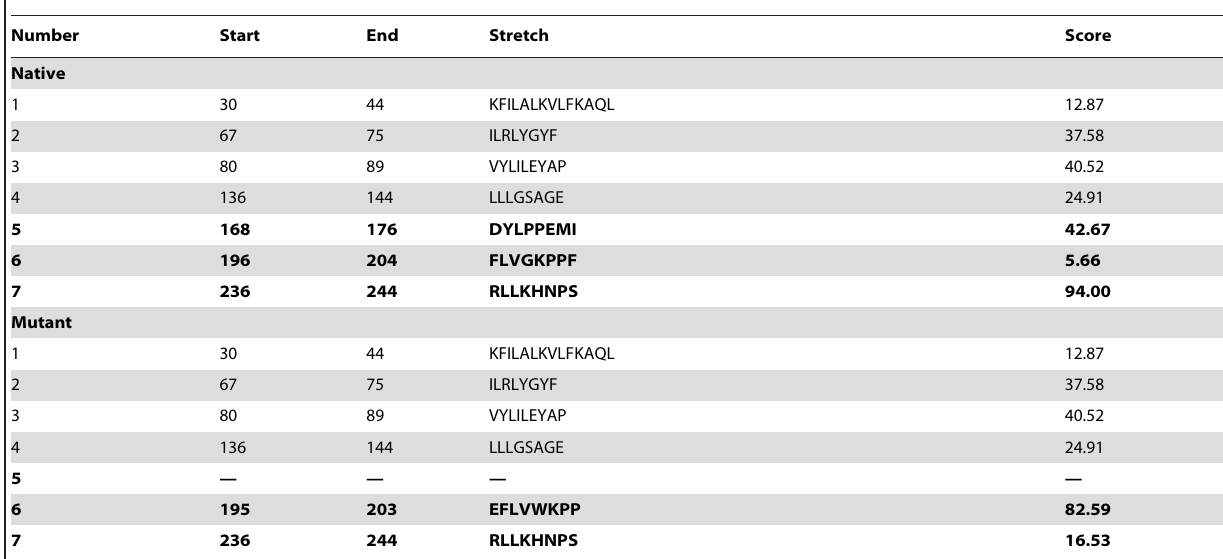
Table 2. LIMBO regions in mutant and wild